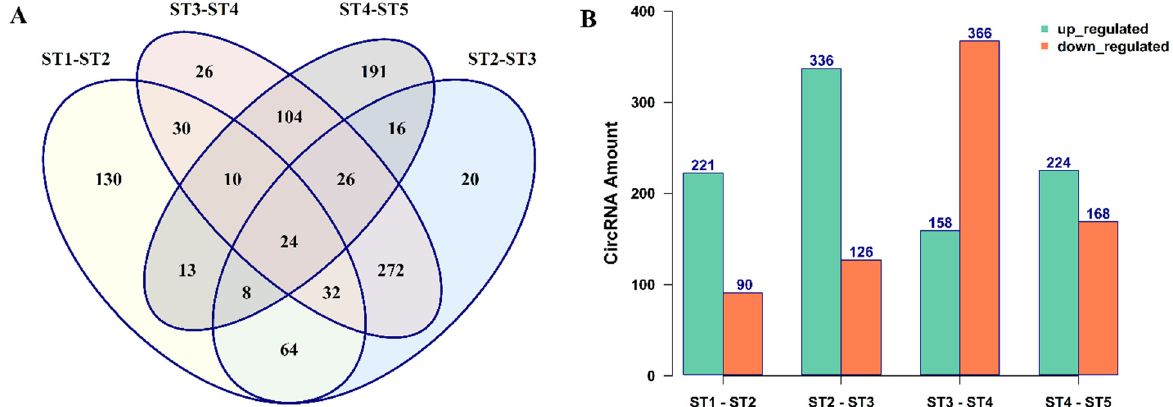
Figure 4. Differential expression patterns of circRNAs during pollen development in B. rapa . ( A ) A Venn diagram showing the number of differentially expressed circRNAs during pollen developmental stages. ( B ) Histograms represent the regulation of differentially expressed circRNAs during pollen developmental stages. ST1: stage 1 (pollen mother cells), ST2: stage 2 (tetrad), ST3: stage 3 (uninucleate pollen), ST4: stage 4 (binucleate pollen), and ST5: stage 5 (mature pollen).